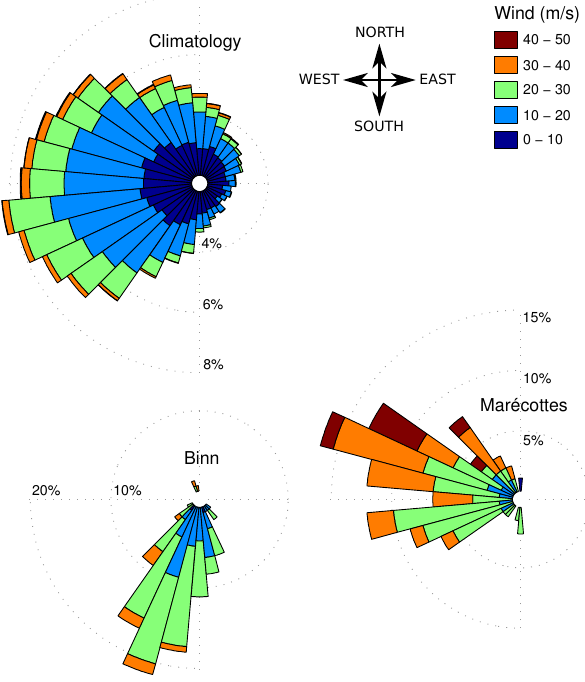
Fig. 6. Wind roses made with the NCEP/NCAR reanalysis dataset at the central point of the catchment on the 500hPa level; wind roses of the climatology and of the days with precipitation above 50mm at the Binn and Mar´ecottes